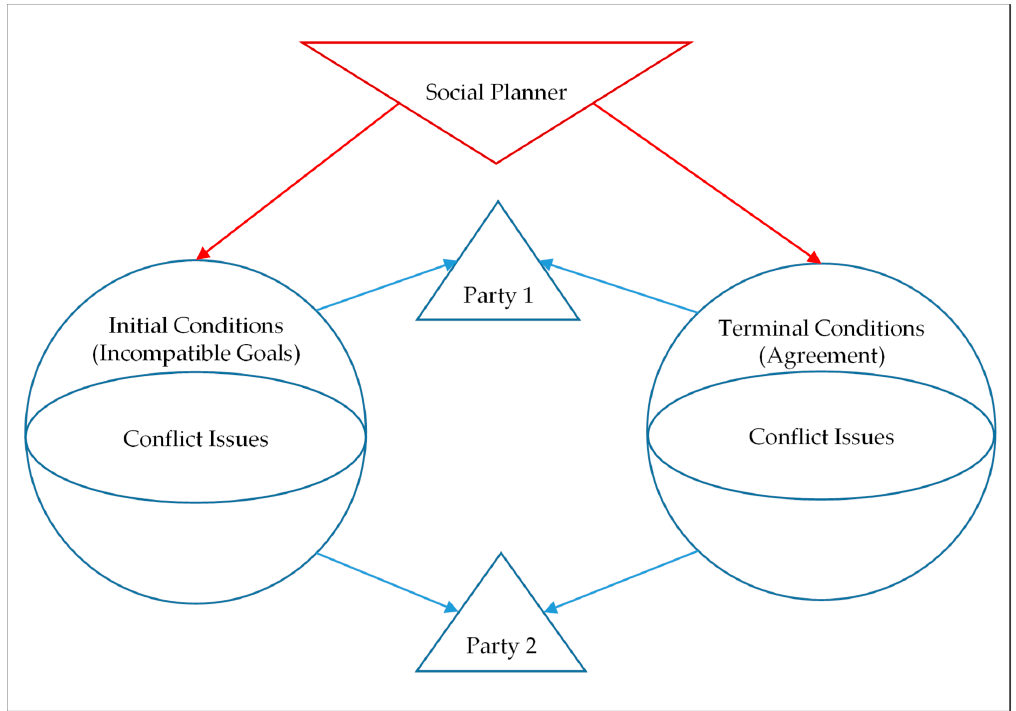
Figure 4. Structure of Social Planner Mechanism.